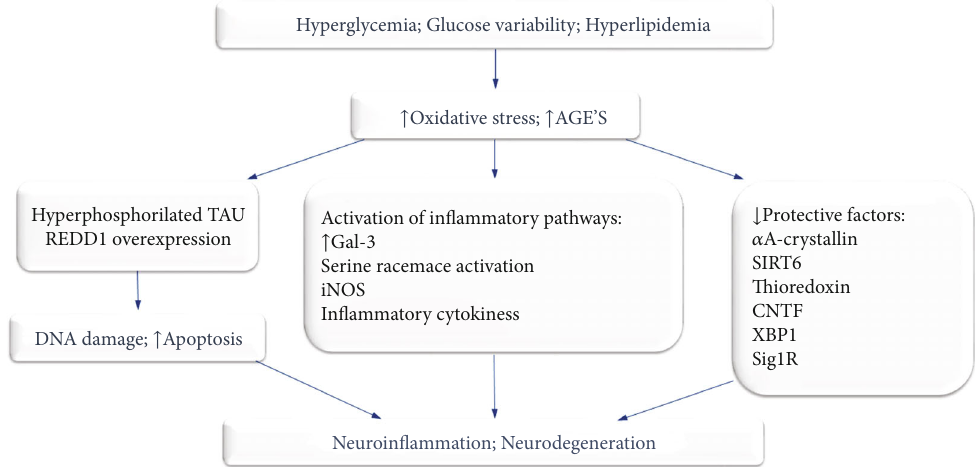
Figure 1: Key mechanisms and recent discoveries in diabetic retinal